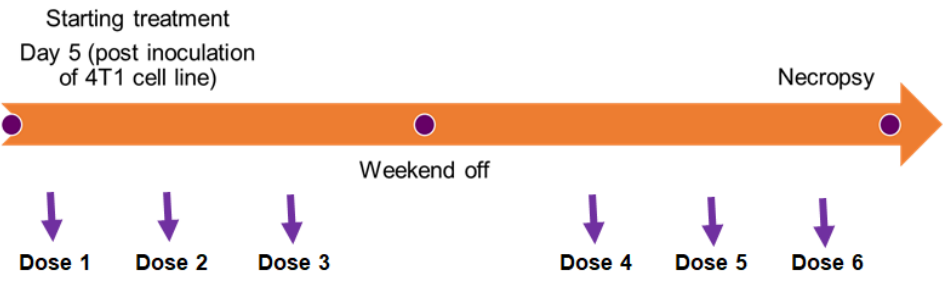
Figure 1. Nanoformulations administration schedule.